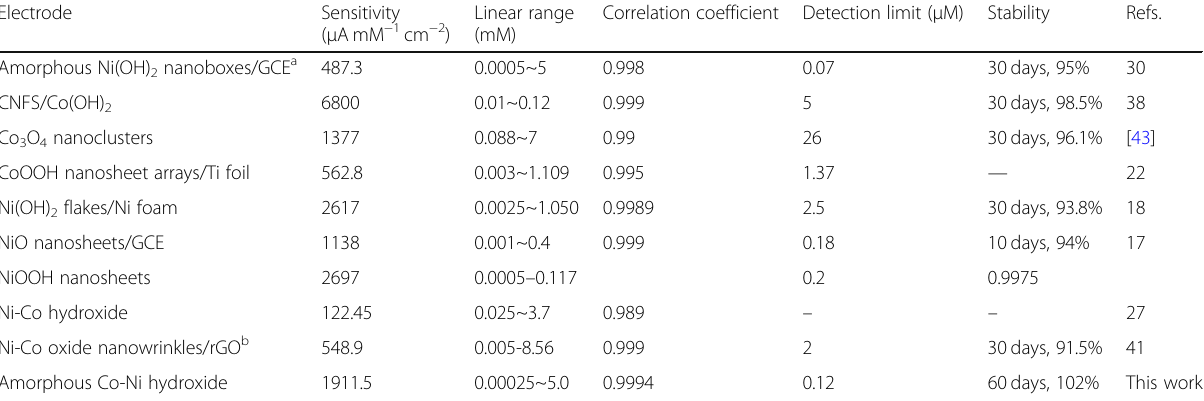
Table 1 Comparison of the sensing performance of non-enzymatic amorphous Co-Ni hydroxide glucose sensor with other reported nickel-based and cobalt-based non-enzymatic glucose sensors